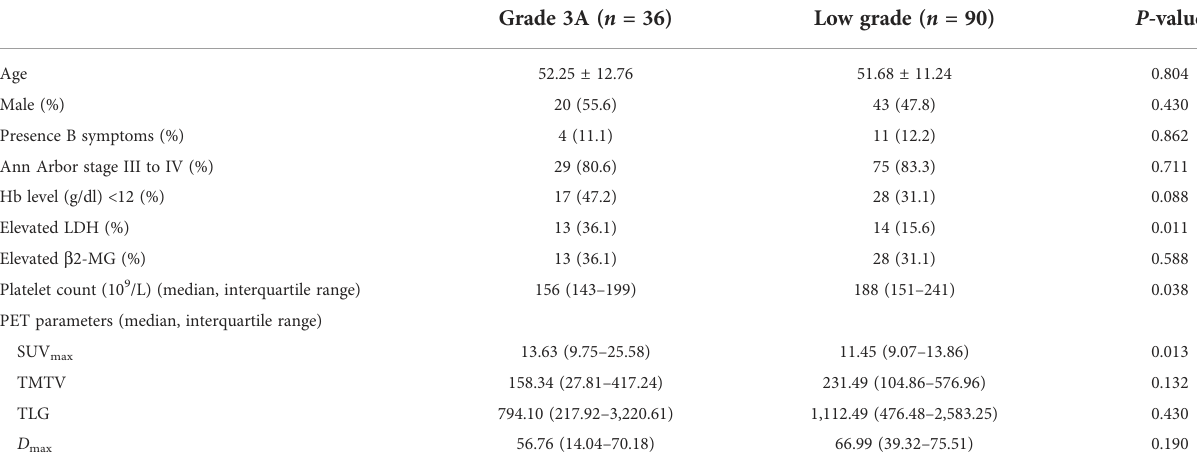
TABLE 5 Comparison of clinical features and PET/CT parameters between grade 3A and low-grade follicular